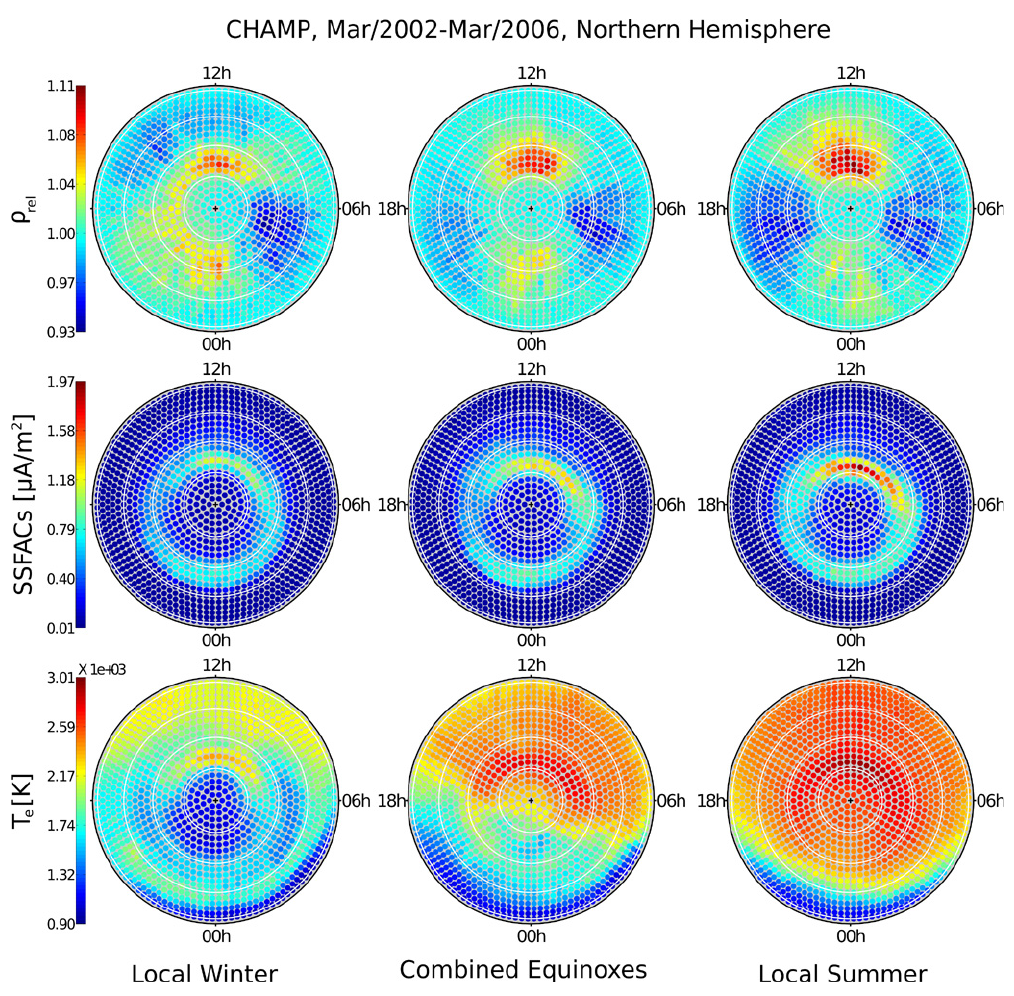
Fig. 3. The bin-averaged median values of density anomaly ρ rel , SSFACs, and electron temperature T e from top to bottom, respectively, for the three local seasons: winter (left column), combined equinoxes (middle column), and summer (right column). The white circles mark the MLat at 10 ◦